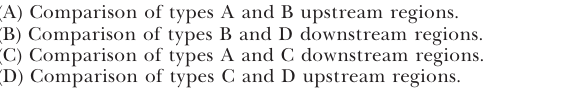
Table S2. Common and Specific TFBSs in the Four TSS Types PEs are compared relative to the same GC richness and same location (upstream or downstream) in different TSS types. The signs plus or minus indicate whether the PE was found to be significantly enriched in the considered region for the considered TSS type. For example, the first column (yellow), which shows comparison between the AT- rich downstream domains in TSS types B and D, contains a common element denoted as ‘‘ þ (cid:2) Ets. ’’ This means that Ets was found significantly enriched for the B type, but its enrichment was not significant for D type. When an element is unique for one or another group, then it is associated only with one plus or minus sign. Table S3. List of Significant PEs Unique and Common for Different TSS Types in the Upstream and Downstream Segments The yellow highlighted TFs are unique for the considered groups when compared with the same upstream or downstream segment of another TSS type with the same GC richness. Table S4. GO Categories That Preserve Enrichment in Specific TSS Types between Human and Mouse We considered only those TSSs whose generated transcripts belong to the same homology group as defined on the NCBI Web site (ftp://ftp. ncbi.nih.gov/pub/HomoloGene). We only considered GO categories that were supported by at least 60 TSSs and where the target TSS type was supported by at least three TSSs. Table S5. All GO and Tissue-Specific Libraries with Distribution of TSSs across the Four TSS Types in Mouse The table presents the total number of TSSs associated with the category (GO or expression library), the number of TSSs of individual TSS type, the percentage of TSSs in that TSS type, enrichment of TSSs in the TSS type relative to what can be expected based on the distribution of all TSSs in mouse across all four TSS types, and Bonferroni corrected p -values calculated based on right-sided Fish- er’s exact tests for the null hypothesis that the proportion of TSS type found in the target group is the same as that of the general mouse distribution. For example, there are 253 transcripts associated with GO:0006955. Of these, 52 transcripts have a TSS of type C. For the number of transcripts in this GO category, one would expect only 11 transcripts with TSSs of type C. Thus, in this GO category, we have 4.85-fold enrichment of transcripts of this type (compared to what we would expect based on the distribution of all transcripts across the four TSS types). If in any of the GO/eVOC categories or tissue libraries, at least one of the TSS groups of transcripts has enrichment that is 1.5-fold or greater than the expected value, we consider such TSS type overrepresented. Found at DOI: 10.1371/journal.pgen.0020054.st005 (2.9 MB